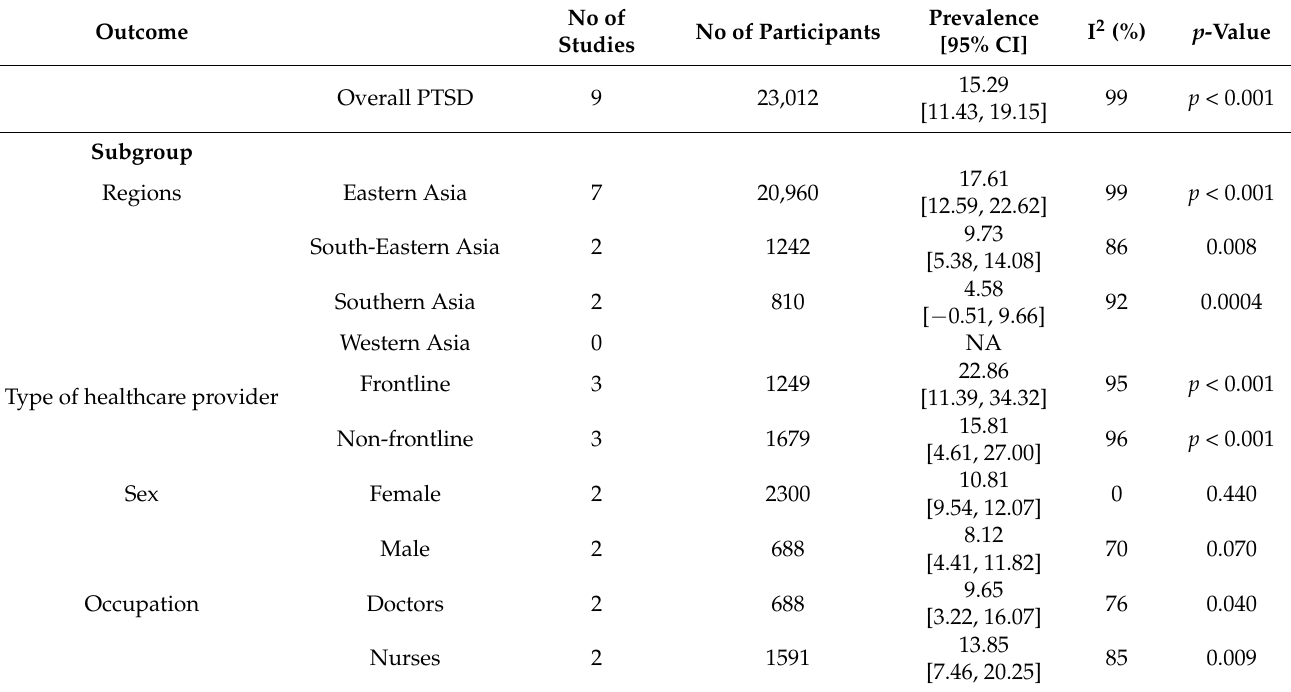
Table 5. Pooled prevalence of PTSD and subgroup